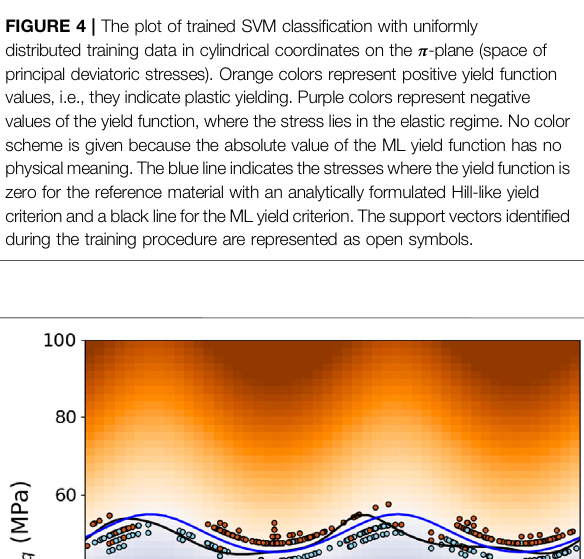
FIGURE 6 | Confusion matrix for uniformly distributed load cases.